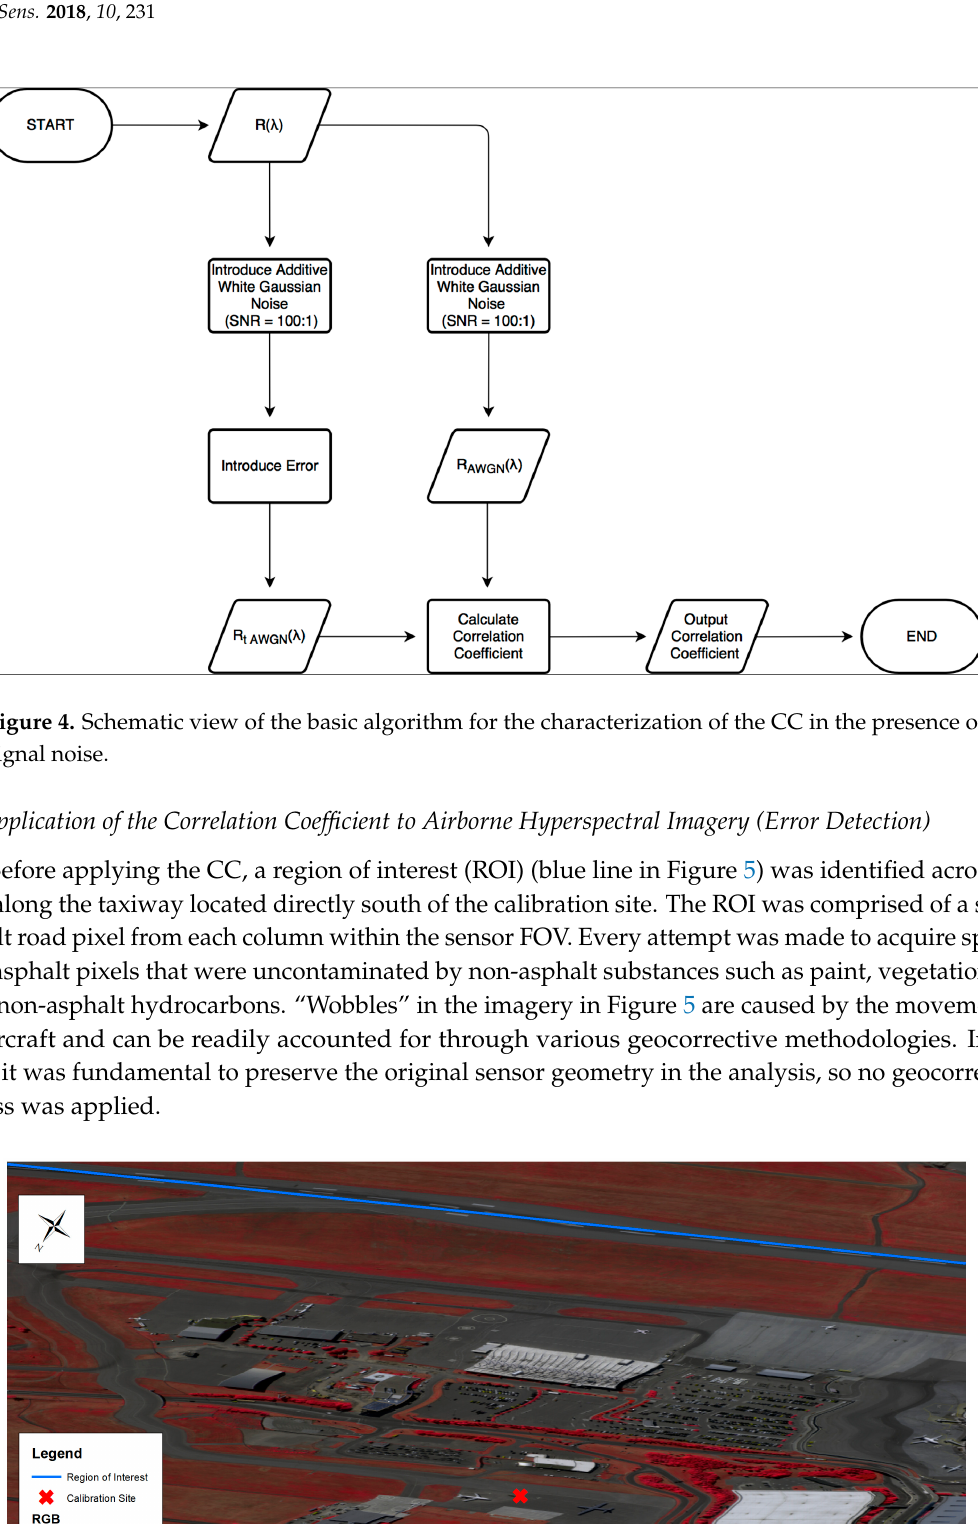
Figure 5. Non-geocorrected CASI imagery of the data acquisition site. The blue line indicates the ROI selected for the analysis. The ROI contained a single pixel from each column across the asphalt road. Ground calibration measurements were taken on the asphalt surface located by the red X, in accordance with Figure 2.